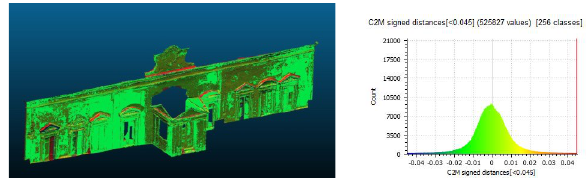
Figure 10. Textured 3D model.